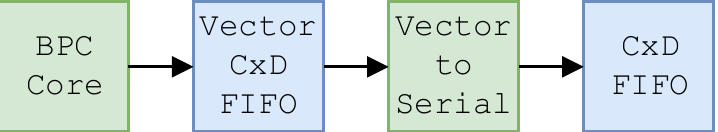
Figure 8. BPC architecture. The BPC core generates up to 10 CxD pairs per cycle, which are then serialized before sending them to the CxD